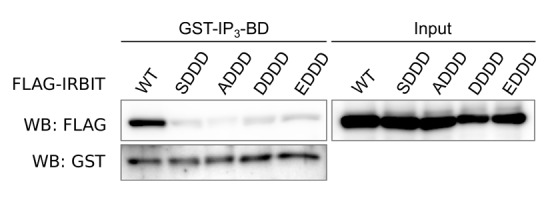
Western blot of GST-pulldown performed with GST-IP3BD on lysates of HeLa cells expressing FLAG-IRBIT (WT) or FLAG-tagged mutants of IRBIT.Mutations: SDDD: S71D, S74D and S77D; ADDD: S68A, S71D, S74D and S77D; DDDD: S68D, S71D, S74D and S77D; EDDD: S68E, S71D, S74D and S77D.